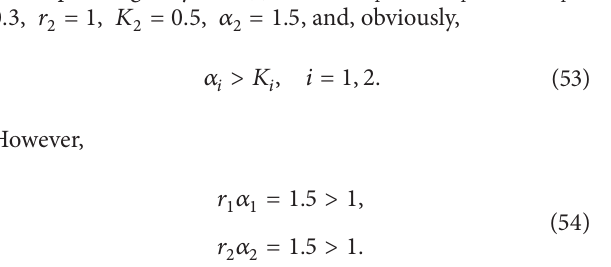
Figure2:Dynamicbehaviorsofthesolution (𝑥 1 (𝑛),𝑥 2 (𝑛)) ofsystem (52), with the initial conditions (𝑥 1 (𝑠),𝑥 2 (𝑠)) = (0.8, 0.4) , (0.5, 0.5) , and (1.5, 1.5) , 𝑠 = ⋅⋅⋅ , −𝑛,−𝑛 + 1,...,−1,0 ,